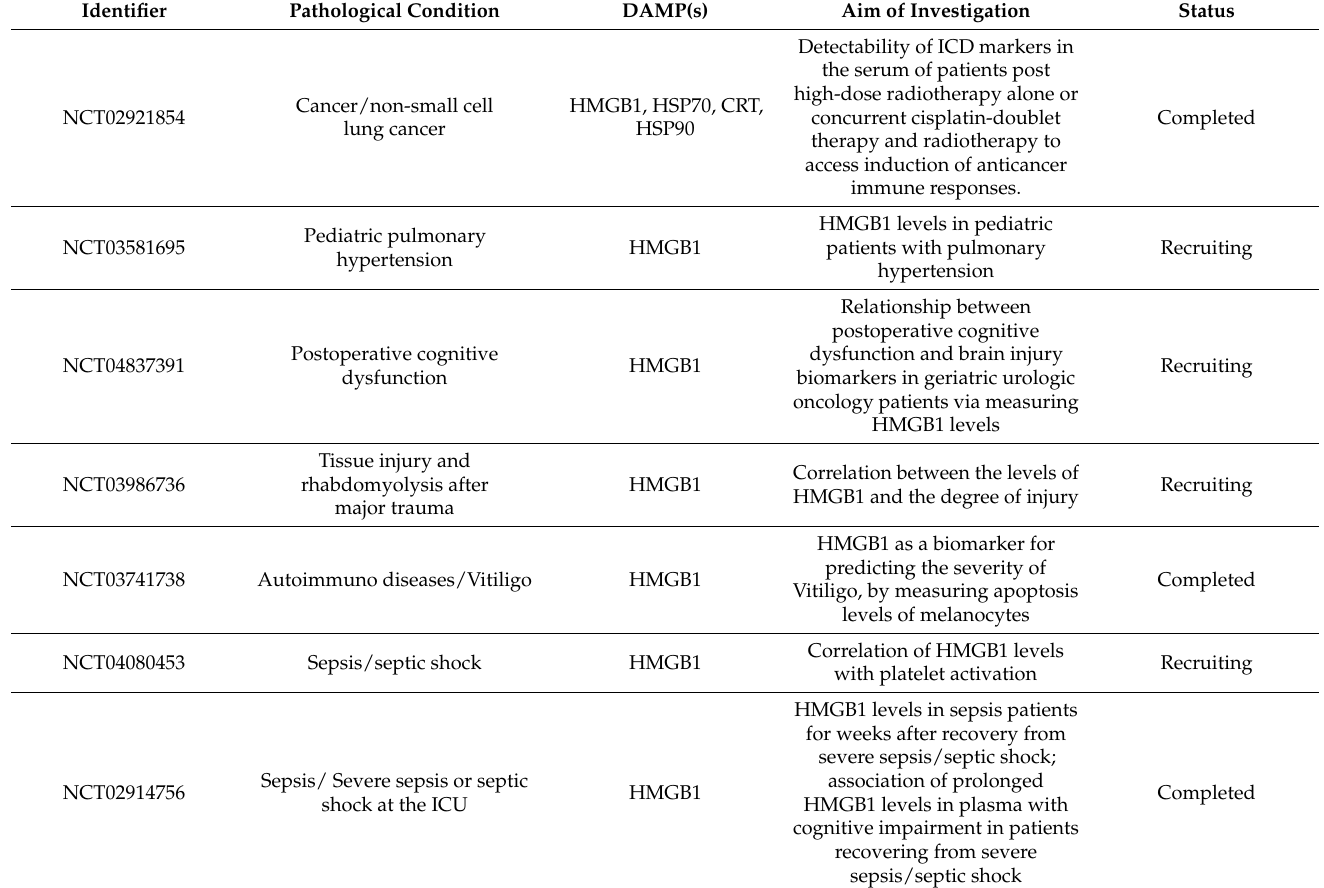
Table 2. Clinical trials evaluating ICD markers in various